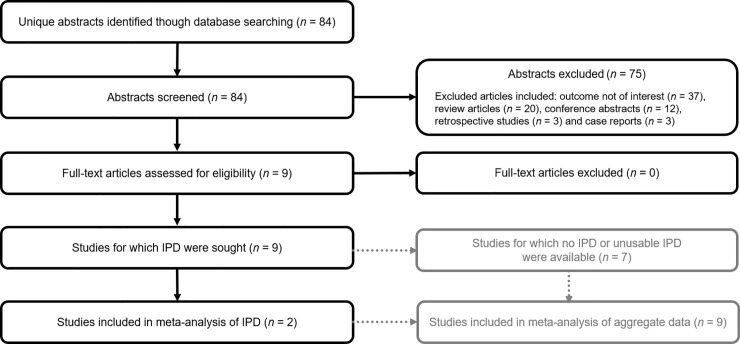
Flow diagram of the process of selecting and excluding studies for the meta-analyses.IPD, individual participant data; IVF, in vitro fertilization.